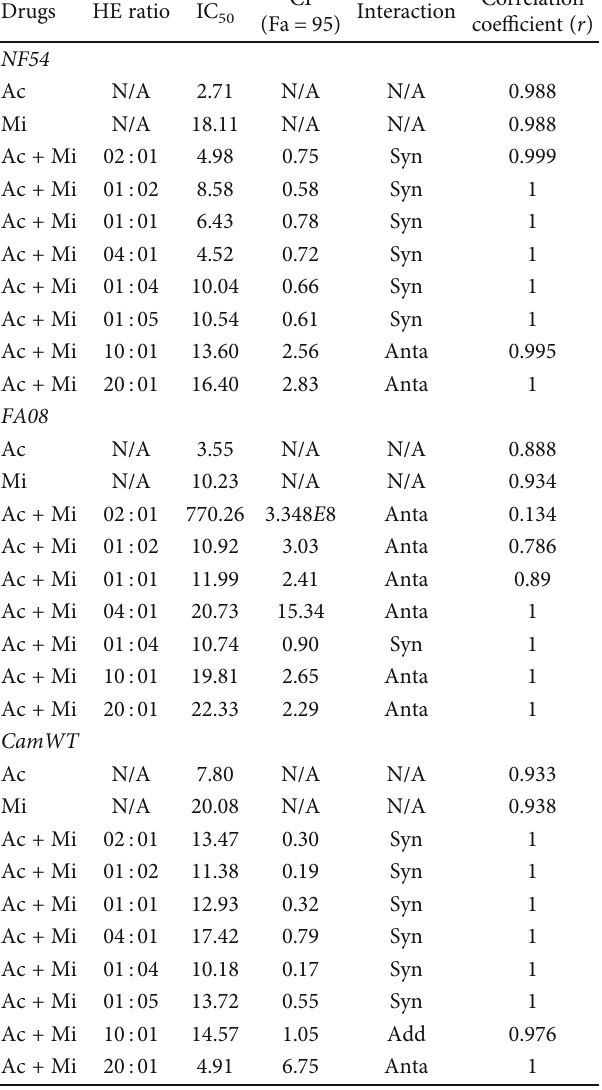
Table 1: The drug c ombination of A . cordifolia with M . indica against NF54, FA08, and CamWT_C580Y Plasmodium parasite strains.